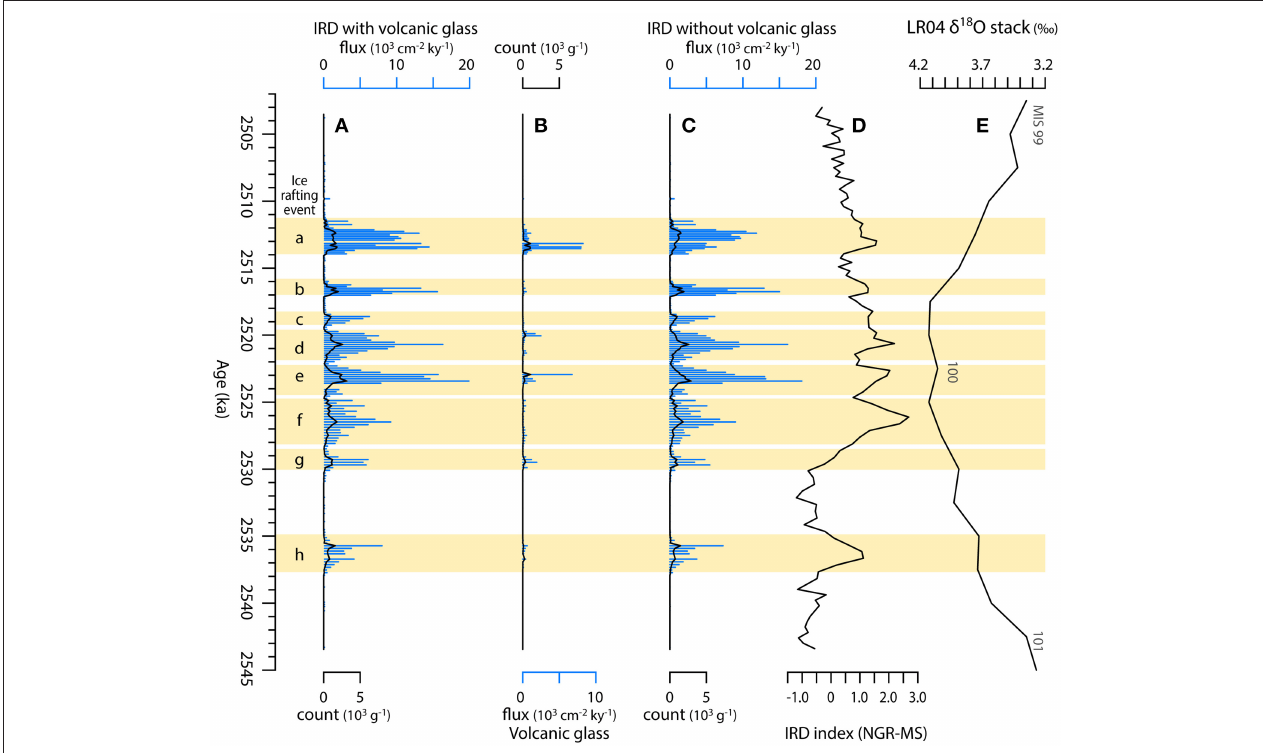
FIGURE 2 | Records of IRD during the MIS 100 glacial period from IODP Site U1314. (A) IRD with volcanic glass (coarse fraction: > 150 µ m); (B) Volcanic glass (coarse fraction: > 150 µ m); (C) IRD without volcanic glass (coarse fraction: > 150 µ m); (D) IRD index by Hayashi et al. (2010) with the age model by Sato et al. (2015); (E) The LR04 stack (Lisiecki and Raymo, 2005). In (A) , (B) , and (C) , black curves and blue bars indicate counts and fluxes of IRD, respectively. Eight ice-rafting events (a, b, c, d, e, f, g, and h) recognized by IRD are shown on the left.